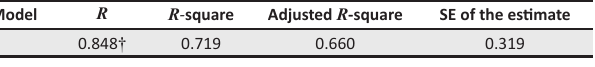
TABLE 8: Model summary. Model Adjusted R